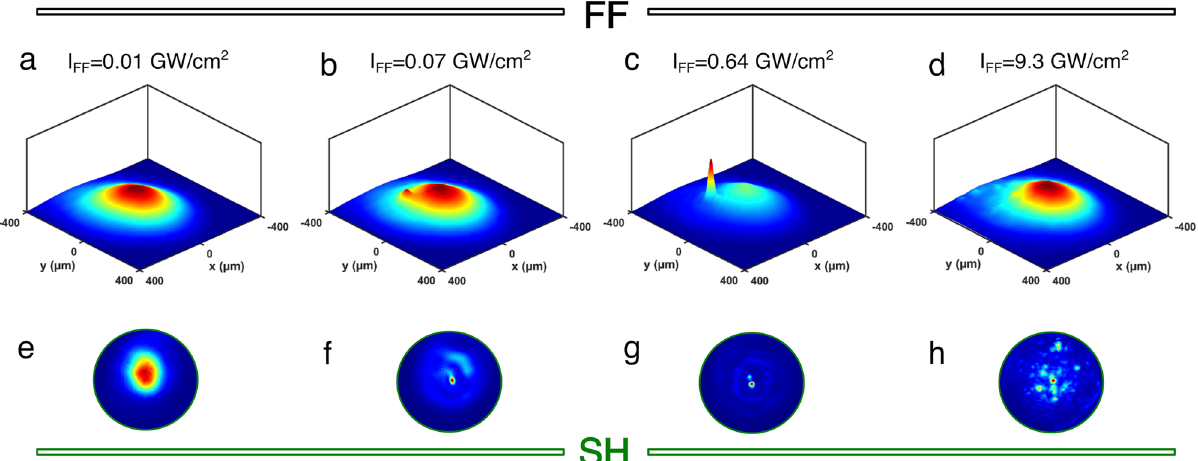
Fig. 2 Output twin spotlight beam (TSB) pro fi les when increasing the input beam intensity IFF. a – d Refer to the fundamental frequency (FF). e – h Show the corresponding second harmonic (SH) intensity pro fi le. Color gradient goes from blue (the lowest light peak intensity) to red (the highest light peak